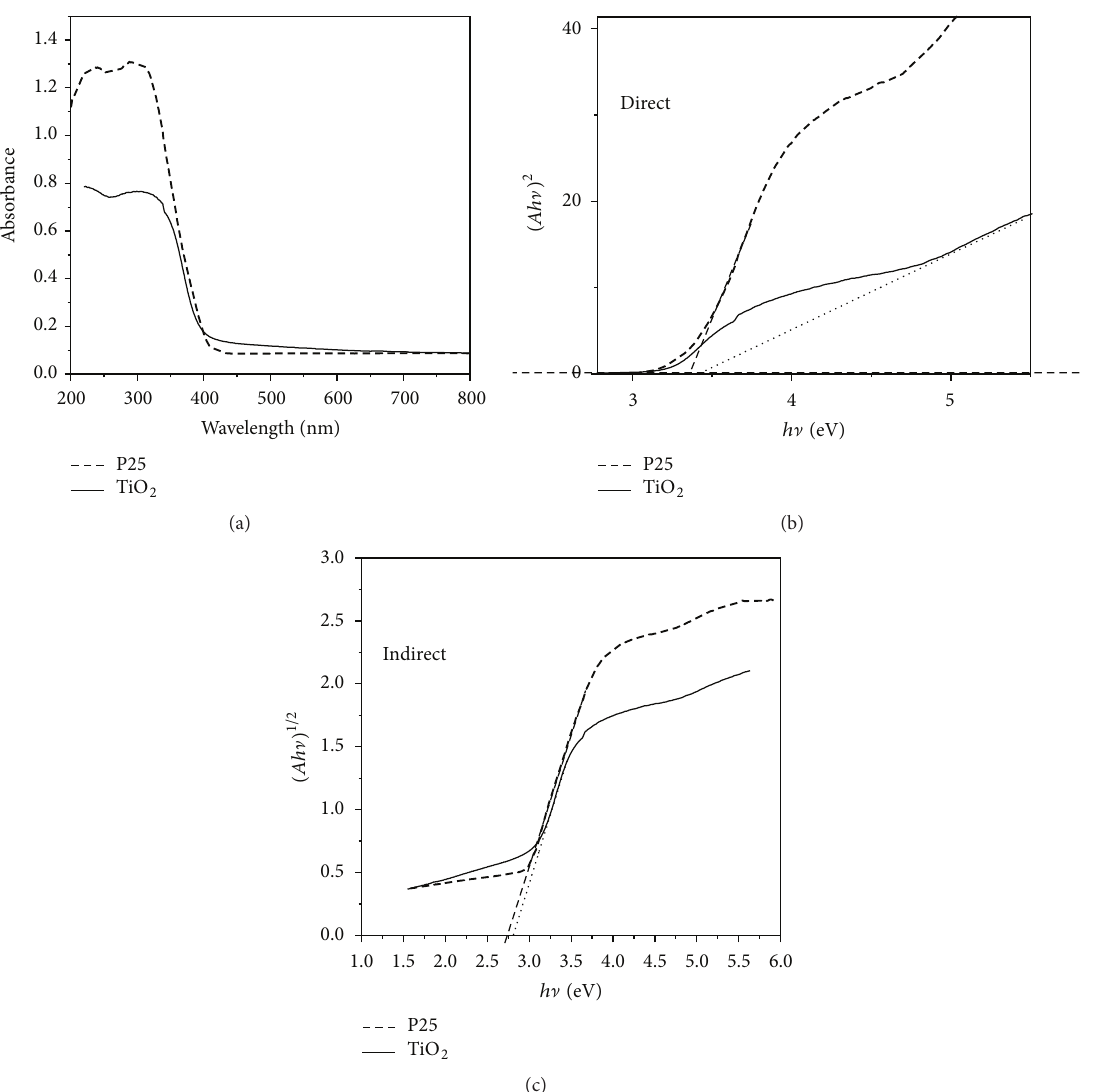
Figure 4: (a) UV-Vis absorption spectra of the TiO 2 nanotubes and P25. (b) The plots of (𝐴ℎ ] ) 2 versus the photon energy (ℎ ] ) . (c) The plots of (𝐴ℎ ] ) 1/2 versus the photon energy ( ℎ ]